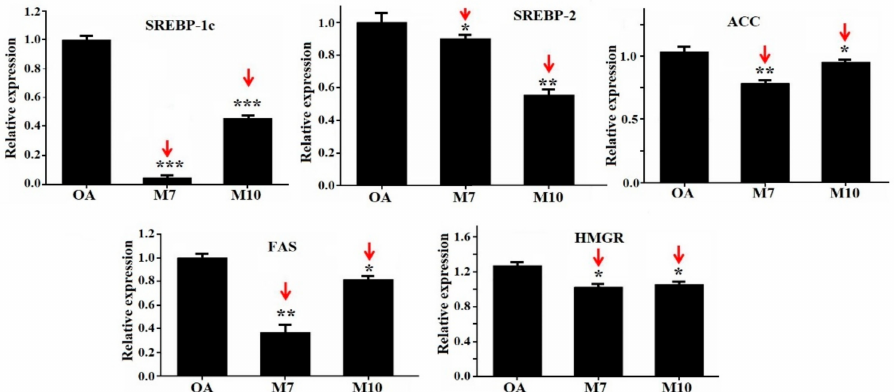
Figure 5. E ff ects of VIAPW (M7) and IRWWW (M10) from miiuy croaker ( M. miiuy ) muscle at a concentration of 100 µ m on the expression levels of genes involved in lipid synthesis (SREBP-1c, SREBP-2, FAS, ACC, and HMGR) in HepG2 cells. Means ± SD (n = 3) are used to express the experiment